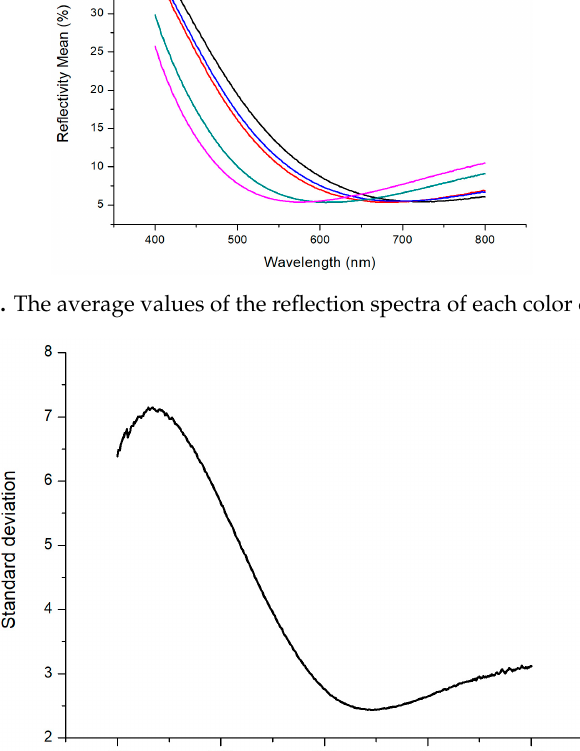
Figure 5. The standard deviation curve of five average values of color categories at different wavelengths. Then, the color value of any cell can be described by the ratio of the reflectivity of the cell at the wavelength 434 nm to the reflectivity of the cell at the wavelength 645 nm wavelength: